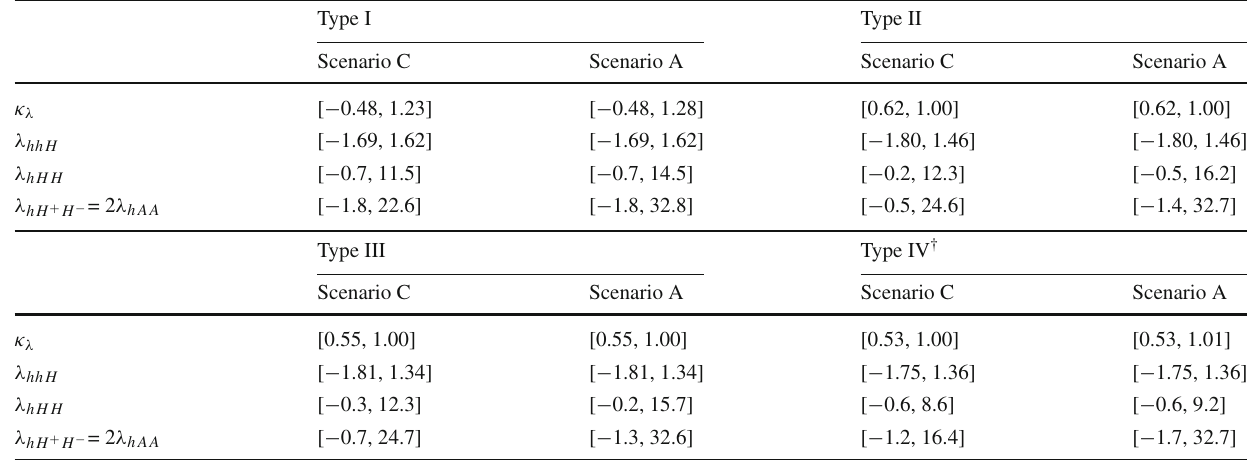
Table 4 Final allowed ranges for the couplings λ hh (for details of the scan, see text). “scenario C” refers to the fully degenerate case with i h j m = m H = m A = m H ± , “scenario A” to the non-fully degenerate case with m A = m H ± and m H being independent mass parameters (see